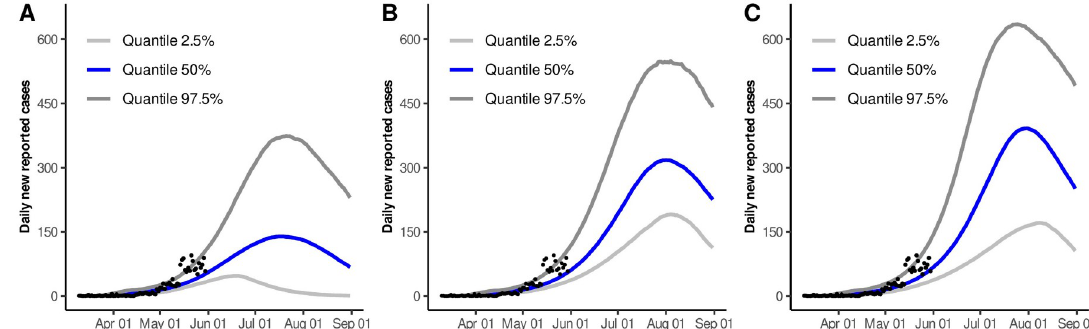
Fig 3. 95% quantile-based intervals and median estimates for the solution curve of daily new reported cases. A) Dynamics for Scenario 1. B) Dynamics for Scenario 2. C) Dynamics for Scenario 3. Black dots represent available data from March 11 to May 31 (accessed on July